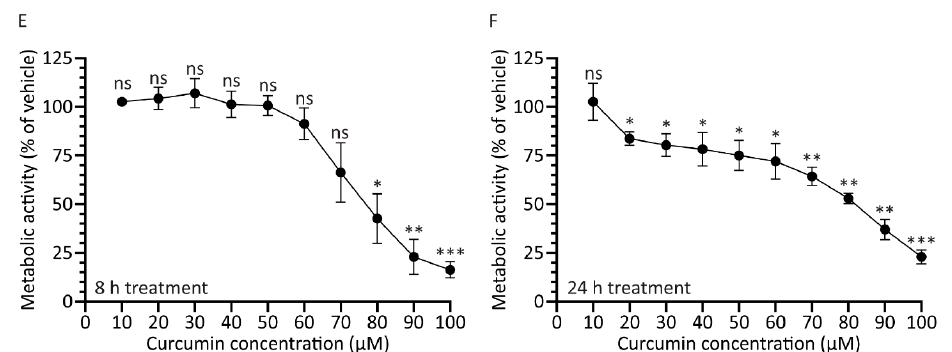
Figure 7. Treatment with higher purity curcumin improves efficacy against HAdV. A549 cells were infected with HAdV-5 at an MOI of 10 for 1 h and overlaid with medium containing curcumin of higher purity (0, 25, 50, and 100 μ M). ( A ) , ( B ) Samples prepared at 8 hpi were analyzed for the quantity of the early protein E1A. ( C ),( D ) Samples harvested 24 hpi were probed with antibody to HAdV-5 capsid proteins. Images and quantification for penton protein are shown. Signal intensities were quantified using Odyssey CLx imaging system, with each sample normalized to the tubulin loading control. ( E ),( F ) A549 cells in 96-well plates were incubated with medium containing higher-purity curcumin from 0–100 μ M. Cellular metabolic activity was determined 8 ( E ) or 24 ( F ) h later. Values are plotted relative to vehicle-treated cells. The mean of three experiments are shown, and the error bars represent standard deviation (SD) of the mean. * p ≤ 0.05, ** p ≤ 0.01, *** p ≤ 0.001, **** p ≤ 0.0001, ns p > 0.05.